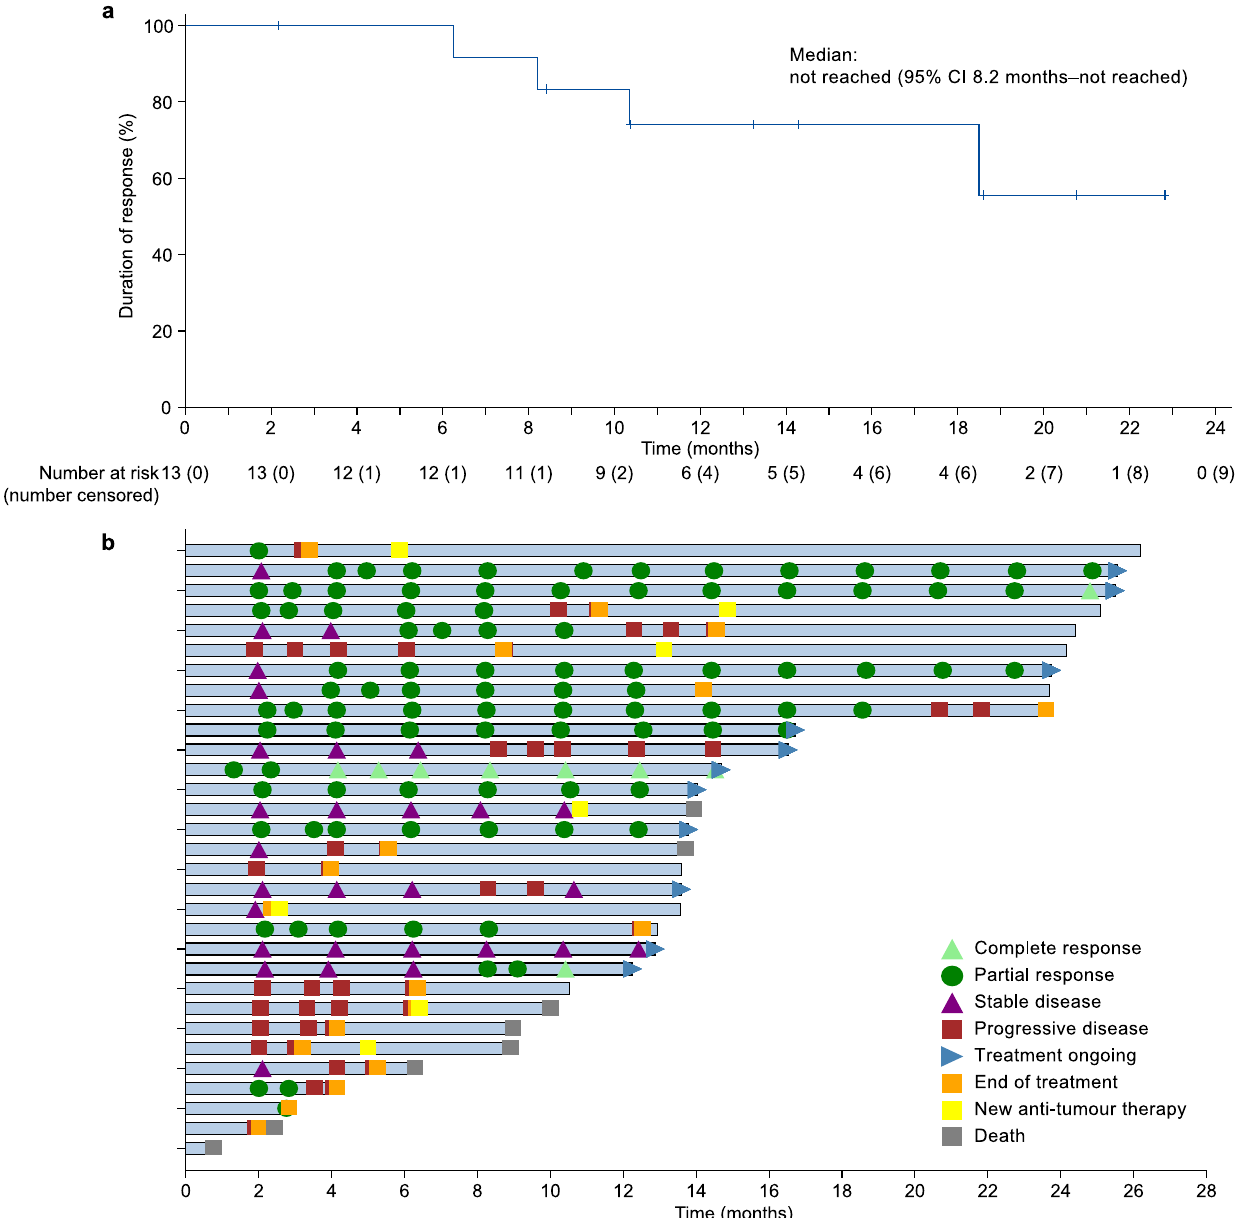
Fig. 2 | Duration ofresponse. a Kaplan – Meier curve of duration of response.Data are for the 13 patients with con fi rmed objective responses. b Swimming plot demonstrating the treatment exposure and duration of tumor response in the full analysis population. Two patients who did not have tumor evaluation results at